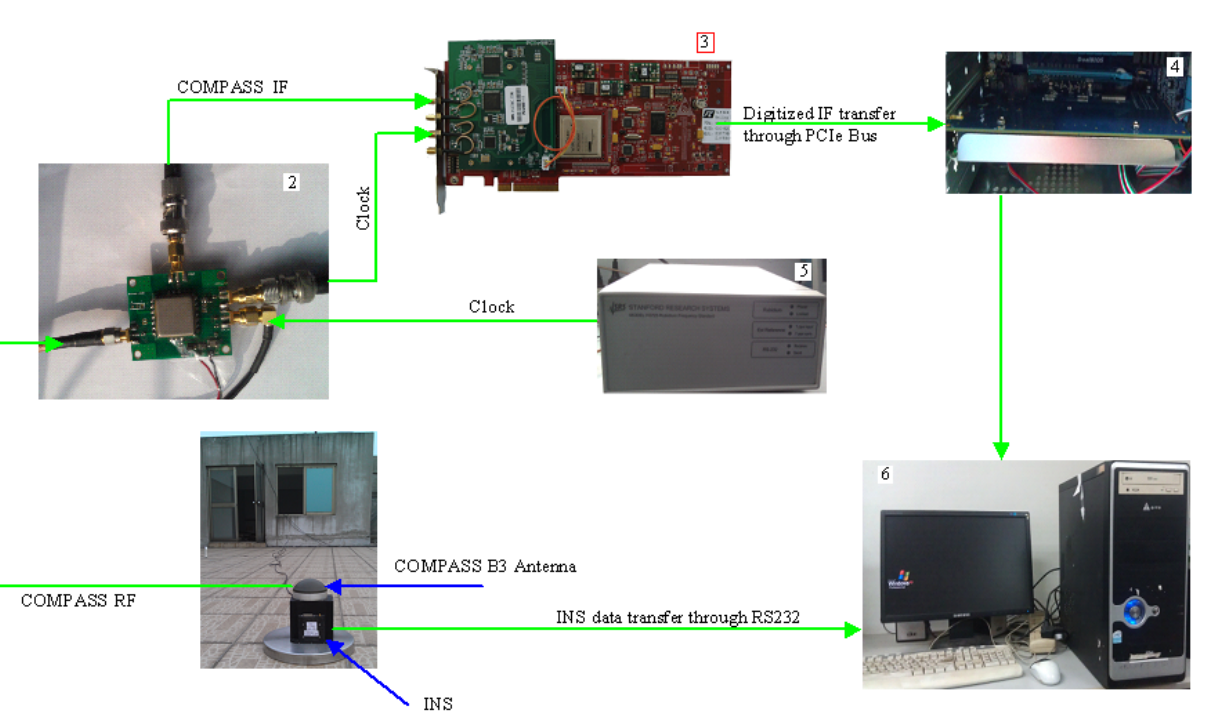
Figure 9. COMPASS IF data and IMU data collection process in field